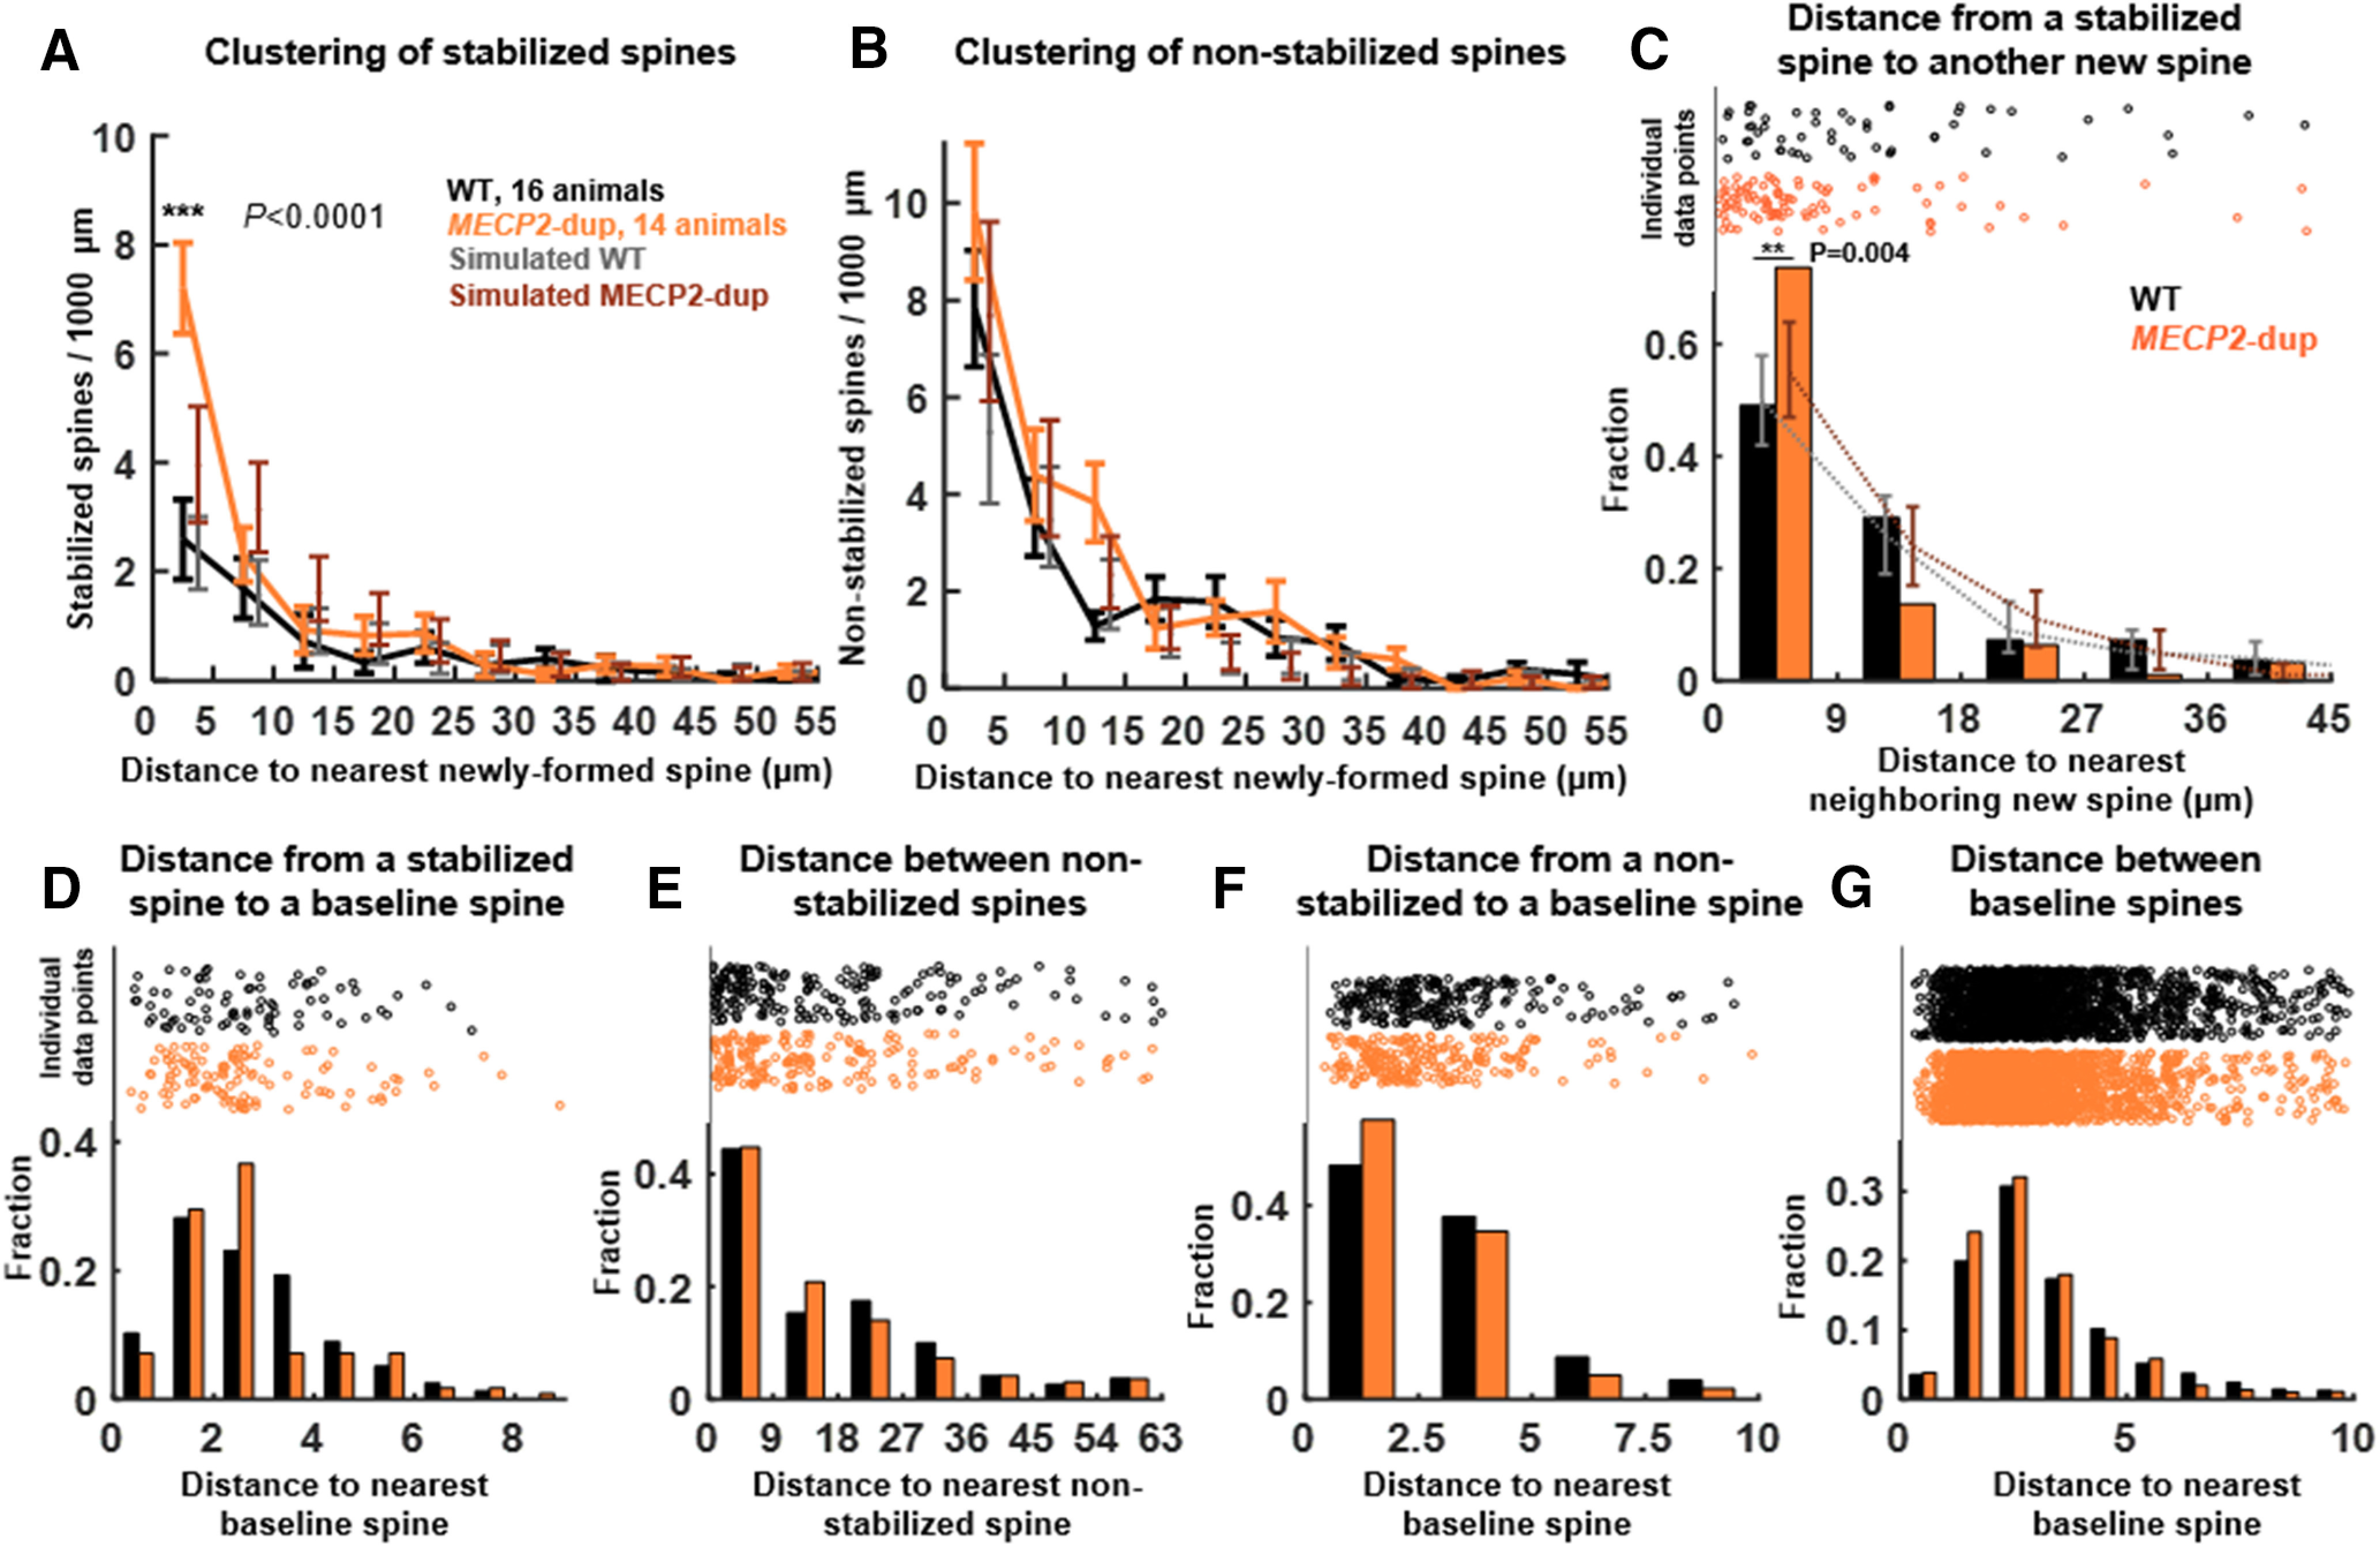
Increased stabilization of dendritic spine clusters in MECP2-duplication mice. A, Mean number of new spines that stabilized per 1000 μm, binned by distance to the nearest neighboring new spine. Bin size = 5 μm; ***p < 10−7, two-way ANOVA with Tukey correction for multiple comparisons, Fgenotype(1,29) = 34.3, Fclusterbin(12,29) = 14.7, Fgenotype × clusterbin(12,29) = 7.6, n = 16 WT, 14 MECP2-duplication animals. Gray and maroon error bars show mean ± 95% confidence intervals of spine distributions predicted by simulation based on measured spine formation and stabilization rates. B, Mean number of spines that formed but did not stabilize per 1000 μm, binned by distance to the nearest neighboring new spine. Gray and maroon error bars depict simulation results. C, Histogram of the distance to the nearest neighboring newly formed spine (whether stabilized or non-stabilized) for each stabilized spine, in MECP2-duplication (orange) and WT (black) mice. Individual data points for each spine are shown at the top; *p = 0.004, Fisher exact test. Gray and maroon error bars depict mean ±95% confidence intervals of the estimated distribution of distances between stabilized spines simulated from the number of spines formed and stabilized per micrometer in each genotype (see Materials and Methods). Differences in overall spine formation and stabilization in mutants do not explain the increase in clustered spine stabilization between mutant and WT (p < 0.001, MECP2-duplication data vs MECP2-duplication simulation, boot strap comparison). D, Histogram of distances from each stabilized spine to the nearest preexisting baseline spine. E, Histogram of nearest-neighbor distances between all non-stabilized new spines. F, Histogram of distances from each non-stabilized spine to the nearest preexisting baseline spine. G, Histogram of nearest-neighbor distances between baseline spines. None of the distributions in D–G showed significant differences. Error bars indicate mean ± SEM.